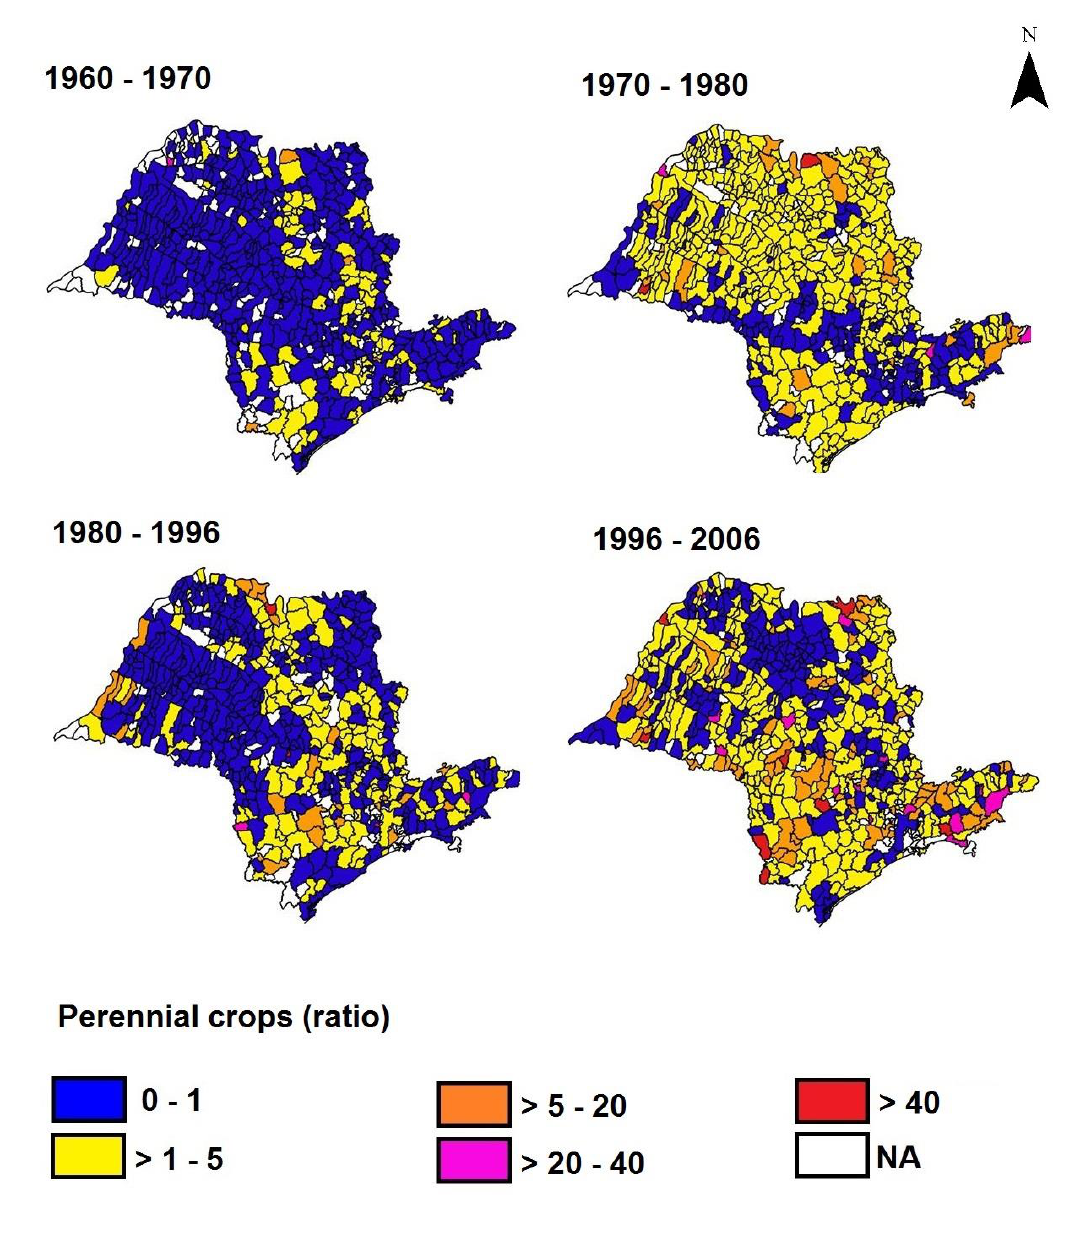
FIGURE A1.6 Perennial crop ratio at the municipality-scale for São Paulo state calculated for the intervals 1960-1970, 1970-1980, 1980-1996 and 1996-2006. Perennial crop ratio was calculated by dividing the perennial crop percentage in one census by perennial crop percentage in the previous census (e.g. values in 1970 / values in 1960). Ratio values greater than 1 (one) indicate that perennial crops increased over the census interval and values lower than 1 (one) indicate that it decreased. Municipality boundaries are shown in black. (NA) Missing